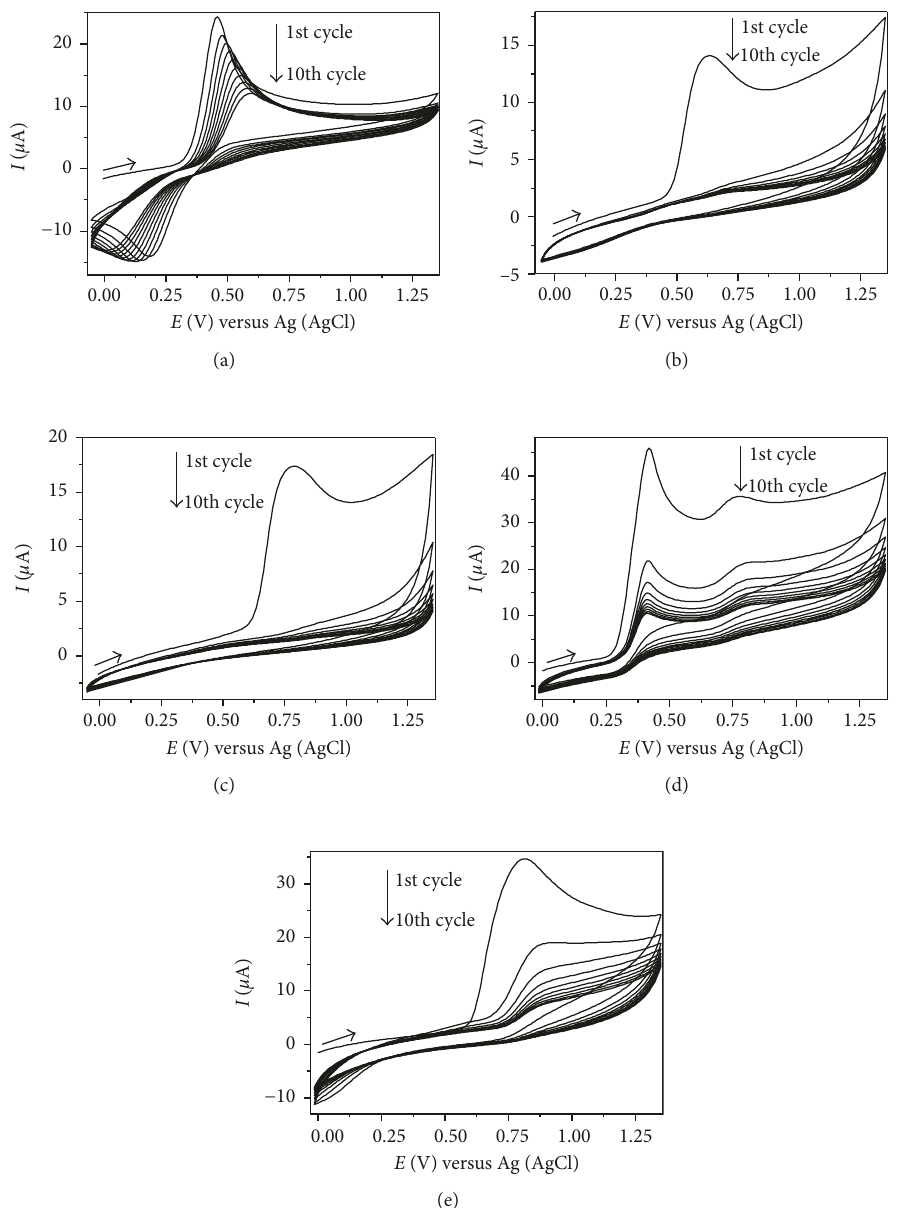
1 acetate buffer (pH 5.0) and potential range of L · −